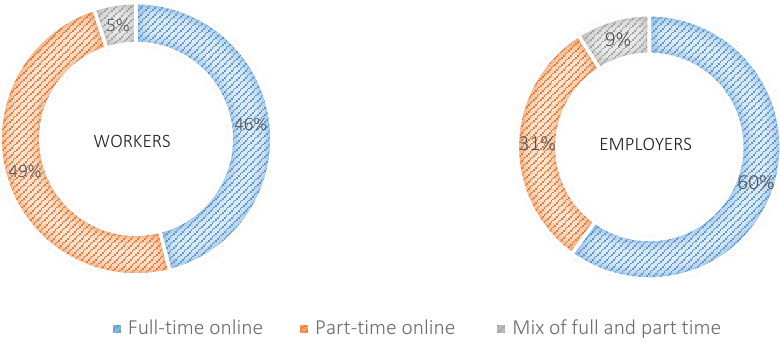
Figure 2. Format of work during the lockdown,